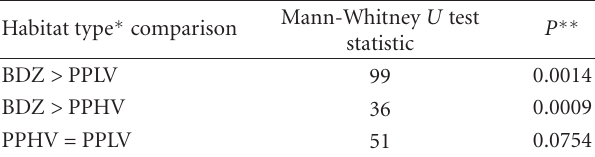
Table 5: Mann-Whitney U tests comparing Shannon-Wiener Biodiversity Indices of ant communities between habitat types at Mount St. Helens National Volcanic